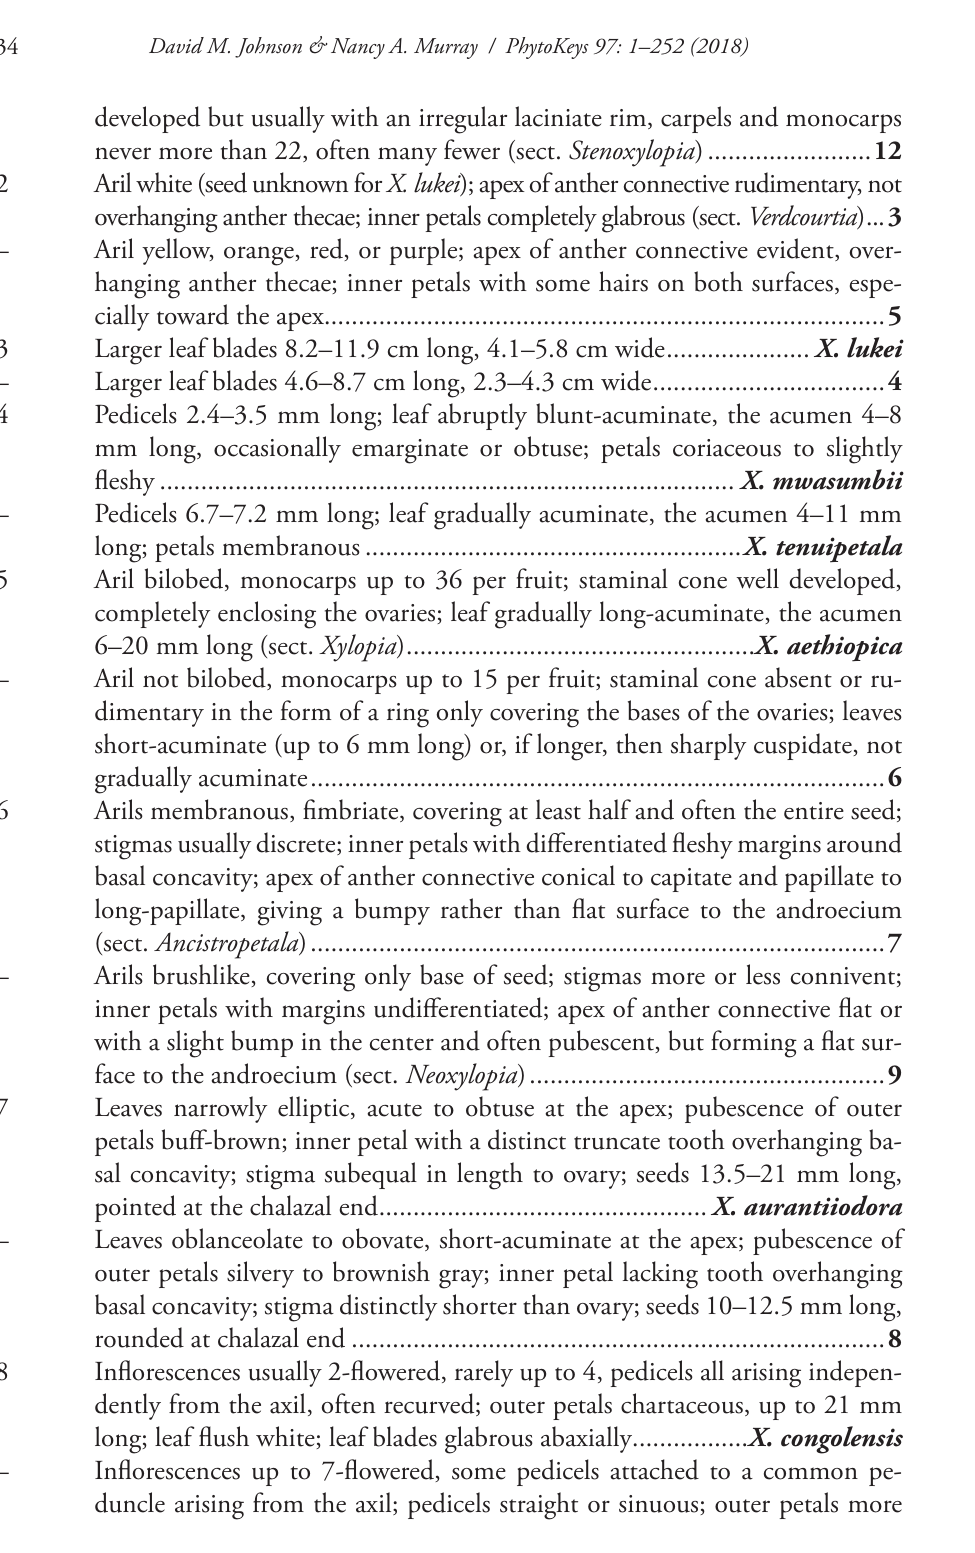
Aril white (seed unknown for X. lukei ); apex of anther connective rudimentary, not overhanging anther thecae; inner petals completely glabrous (sect. Verdcourtia ) ... 3 Aril yellow, orange, red, or purple; apex of anther connective evident, over- hanging anther thecae; inner petals with some hairs on both surfaces, espe-